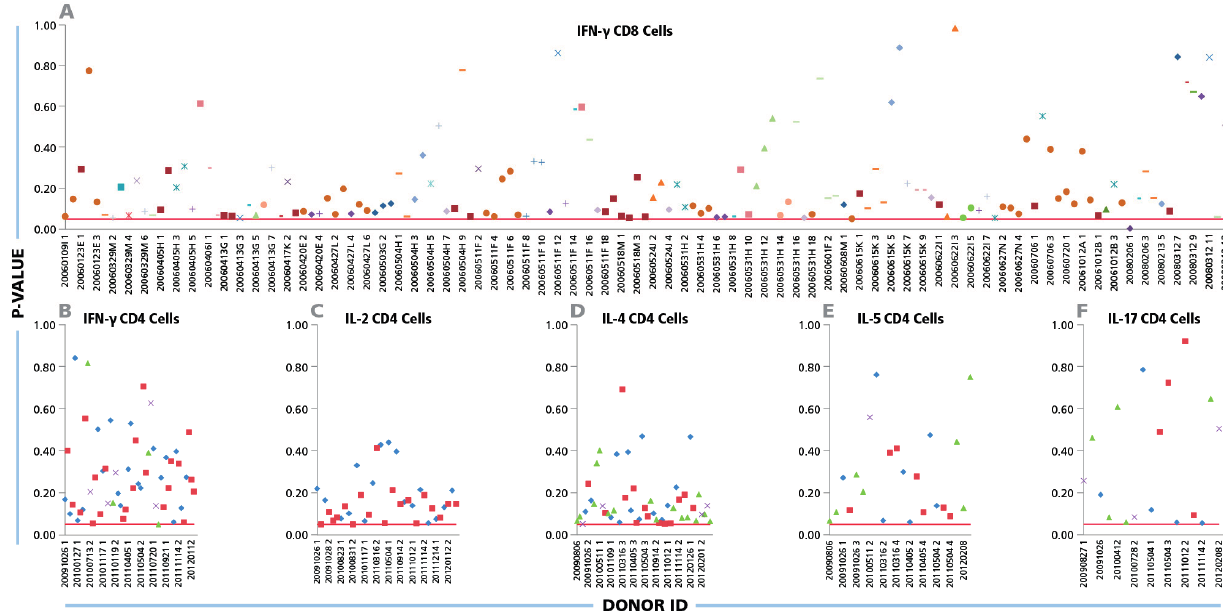
Figure 2. Log Normal size distributions for cytokine ELISPOTs produced by CD8 and CD4 cells. ( A ) For CD8 cells, IFN- γ ELISPOT size distributions were studied for a total of 334 positive recall responses induced by the 32 individual CEF peptides. Each peptide is represented by an individual symbol type. ( B – F ) For CD4 cells, 80 individual IFN- γ , IL-2, IL- 4, IL-5, and IL-17 spot size distributions elicited by inactivated CMV and EBV were studied; each one specified by a different symbol. The Kolmogorov–Smirnov goodness of fit test was used to determine the normality of spot size distribution for each individual positive recall response. Experimental IDs of the positive donors are shown on the x-axis, and the y-axis represents the p-values for the donor/peptide combinations. The red line indicates the cut-off significance level of